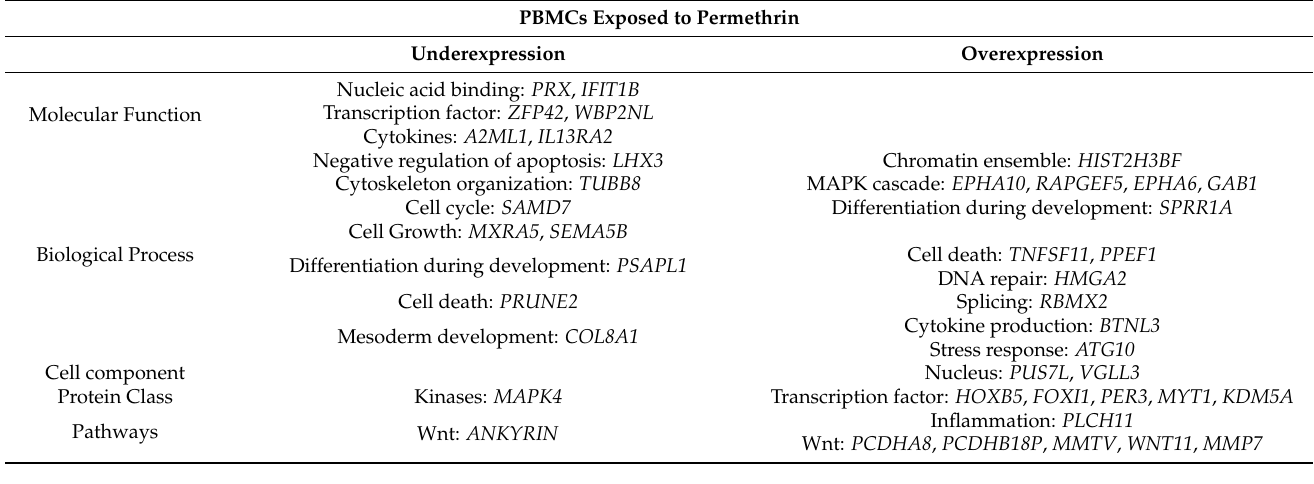
Table 4. Highlights of gene ontology analysis of the top and bottom 100 genes with over and underexpression in PBMCs exposed to permethrin.